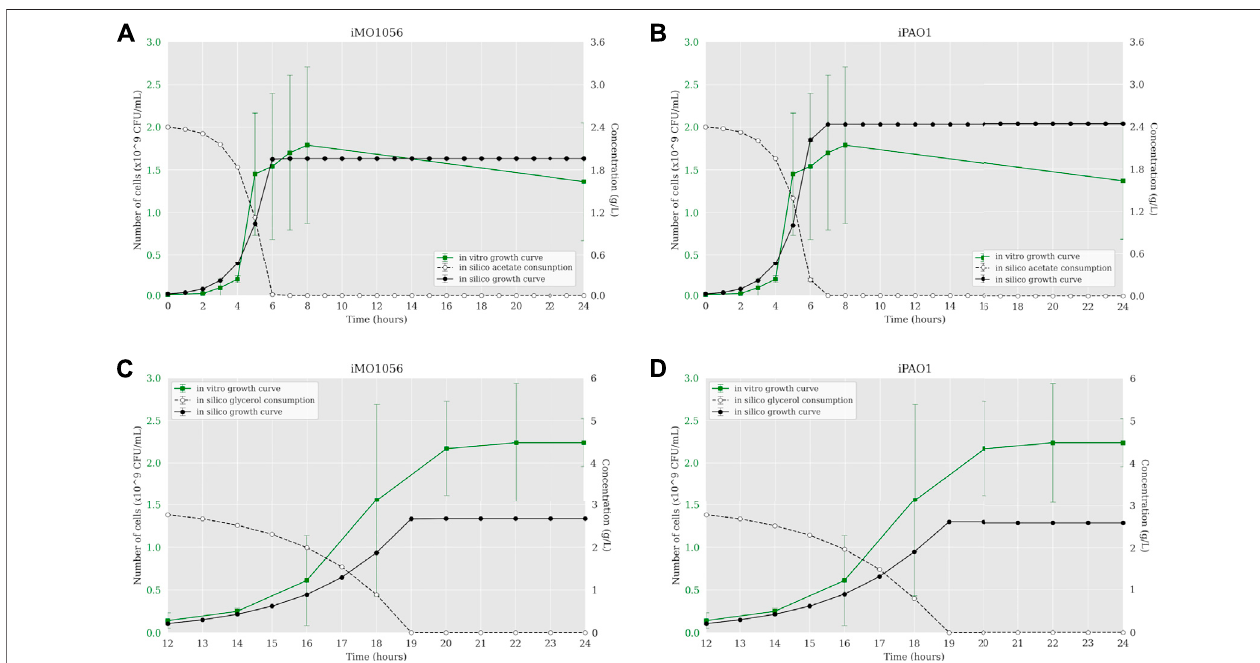
FIGURE 3 | Comparison between P. aeruginosa growth curves predicted by ACBM from the integrated models and growth curves measured by Dolan et al. (2020). (A,B) MOPS minimal medium with acetate as carbon source. (C,D) MOPS minimal medium with glycerol as carbon source. The graphics include the carbon source consumption over time (dashed lines). All measurements were made at least in triplicates and curves represent the mean of all replicates. Error bars are the standard deviation of the